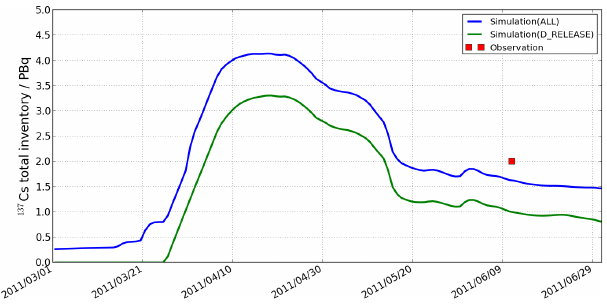
Fig. 11. Simulated total inventories (PBq) in the area of the KOK cruise by ALL, NO INFLOW and D RELEASE